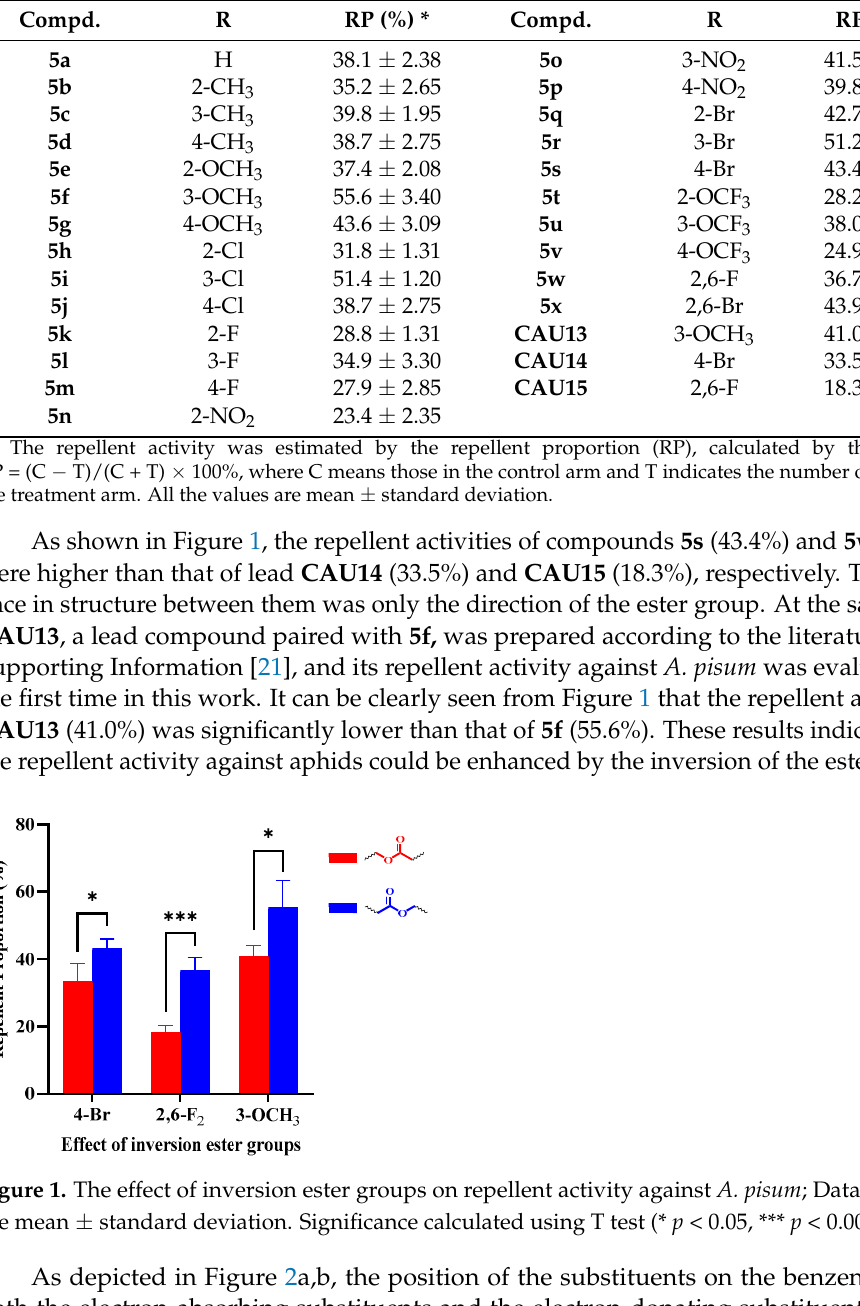
Figure 2. ( a ) The order of the repellency proportion of monosubstituents against A. pisum ; ( b ) The positional effects of ortho- , meta- , and para- substituents on repellent activity. Data represent the mean ± standard deviation. A one-way analysis of variance (ANOVA) was performed followed by Duncan’s test (Different letters indicate values are significantly different ( p < 0.05)). 2.3. The Binding Affinity to ApisOBP9 Insects were repelled mainly due to their olfactory system sensing odor molecules, given that OBPs play an important role in this process. The ApisOBP9 was identified as a key potential target for the repellent activity to aphids in our previous work [23]. Therefore, in order to figure out the reason for the change in repellent activity after the ester group inversion, the binding affinities of the lead compounds and target compounds to ApisOBP9 were determined by a competitive fluorescence binding experiment using N-Phenyl-1-naphthylamine (1-NPN) as a probe. Their binding curves and binding constant (1/Ki) values were shown in Figure S1 and Table 2, respectively.